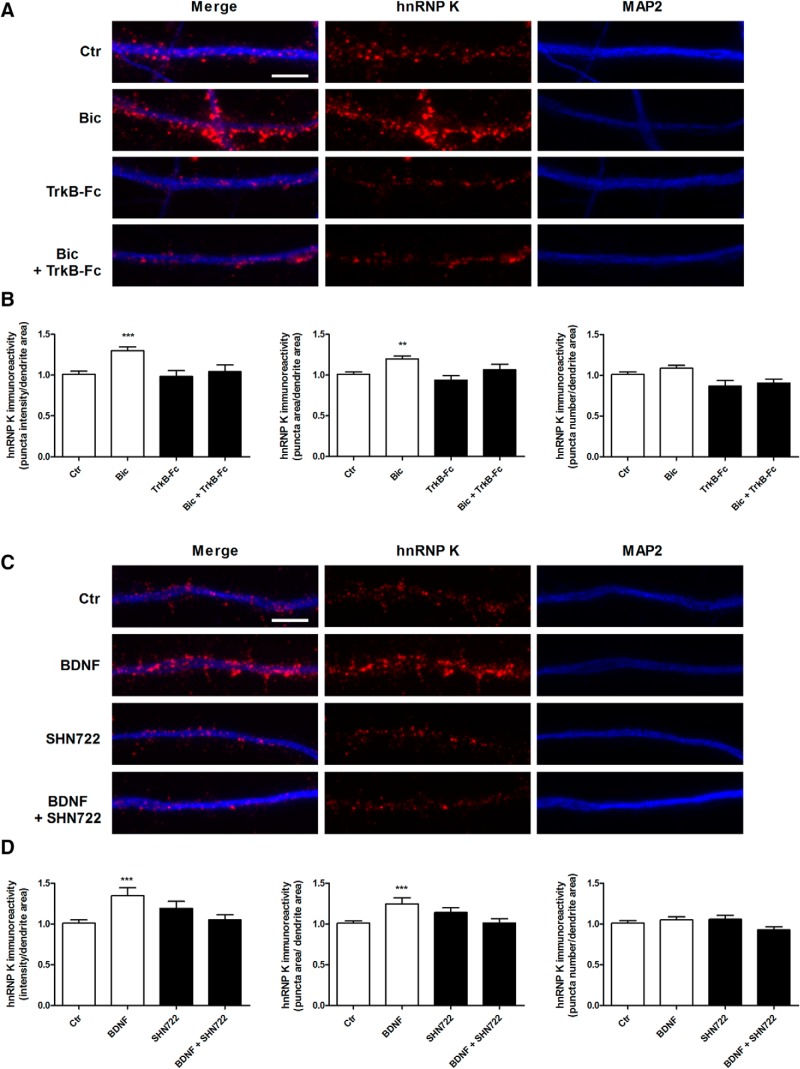
 Activity-induced BDNF-dependent dendritic accumulation of hnRNP K in hippocampal neurons. A, B, Synaptic activity induces the accumulation of hnRNP K in dendrites of hippocampal neurons. Cultured hippocampal neurons (14-15 DIV) were stimulated or not with bicuculline (50 μM), 4-AP (2.5 mM), and glycine (10 μM), for 30 min. Where indicated, neurons were treated with the extracellular scavenger of TrkB ligands TrkB-Fc (1 μg/ml) for 30 min and were then stimulated or not with bicuculline in the presence of the scavenger. Cells were then fixed and immunostained for hnRNP K (red) and MAP2 (blue) (A). The integrated fluorescence intensity, area, and number of hnRNP K puncta in dendrites was analyzed using ImageJ software and represented per dendritic area (B). Results are normalized to control and are the mean ± SEM of 4–10 different experiments performed in independent preparations. Ctr, n = 108 cells; Bic, n = 97 cells; TrkB-Fc, n = 49 cells; Bic + TrkB-Fc, n = 52 cells. C, D, BDNF increases hnRNP K levels in neuronal dendrites. Cultured hippocampal neurons (14–15 DIV) were stimulated or not with BDNF (100 ng/ml) for 30 min. Where indicated, neurons were preincubated with the Trk receptor inhibitor SHN722 for 30 min, and the inhibitor was also present during the period of incubation with the neurotrophin. Cells were then fixed and immunostained for hnRNP K (red) and MAP 2 (blue) (C). The integrated fluorescence intensity, area, and number of hnRNP K puncta in dendrites was analyzed using ImageJ software and represented per dendritic area (D). Results are normalized to control and are the mean ± SEM of 4–10 different experiments performed in independent preparations. Ctr, n = 108 cells; BDNF, n = 53 cells; SHN722, n = 41 cells; BDNF + SHN722, n = 51 cells. Statistical analysis was performed by one-way ANOVA, followed by the Bonferroni’s multiple comparison test. **p < 0.01; ***p < 0.001. Scale bars: 5 μm. Extended Data Figure 1-1 shows that neuronal activity does not change total hnRNP K protein levels in cultured hippocampal neurons.